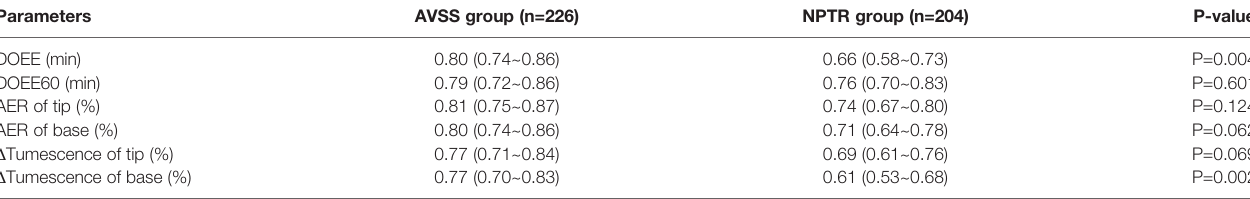
TABLE 4 | Comparison between AVSS group and NPTR group via AUC in cured patients predictions. Parameters